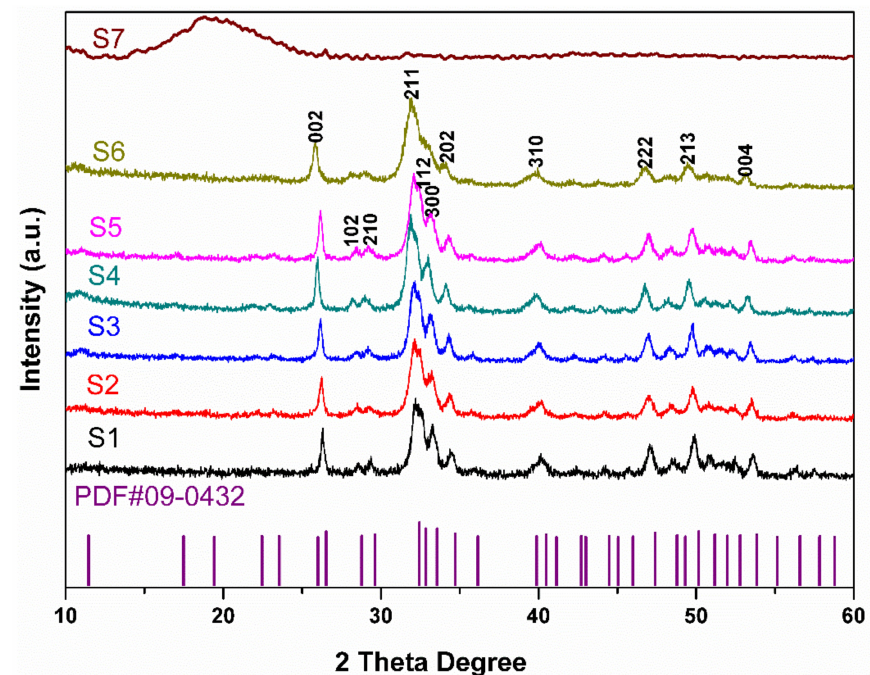
Figure 1. XRD patterns of synthesized HA samples (S1–S5), HA derived from carp scales (S6) and partially hydrolyzed keratin